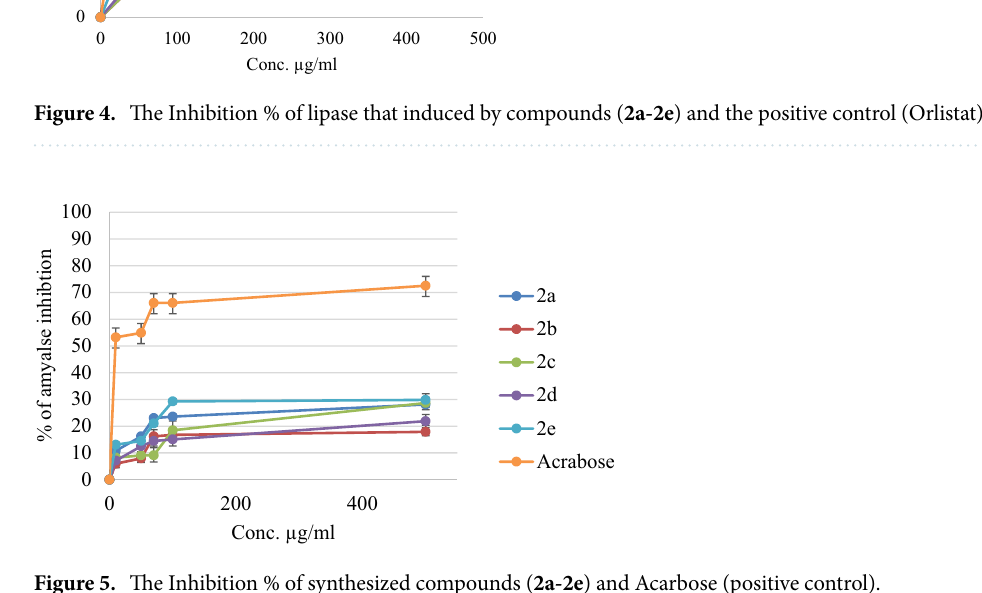
Figure 5. The Inhibition % of synthesized compounds ( 2a-2e ) and Acarbose (positive